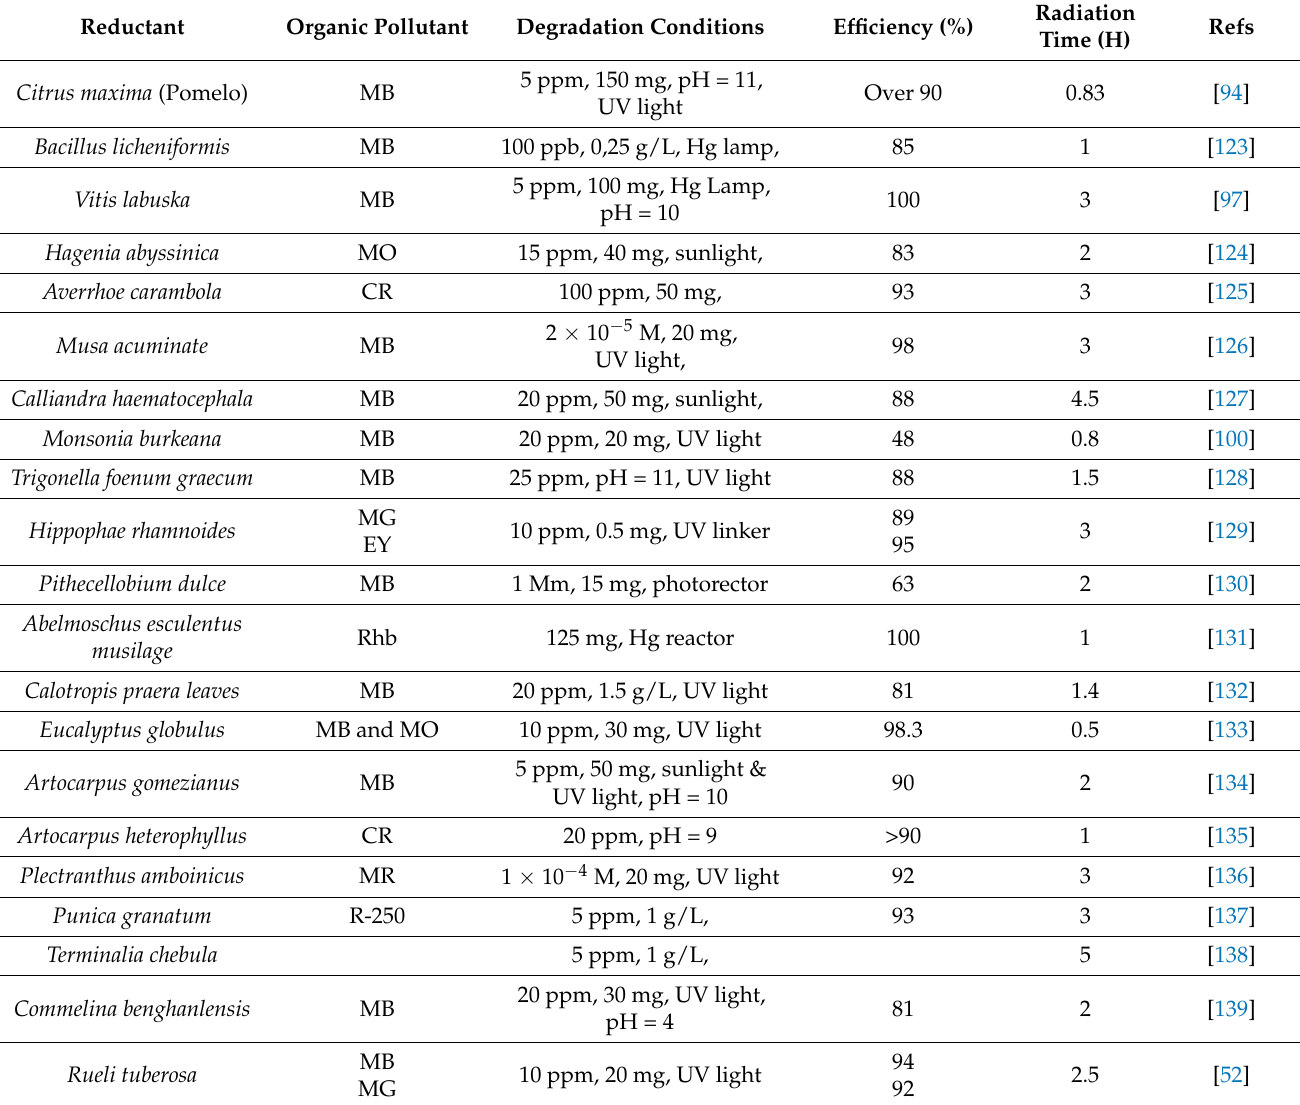
Table 4. Green synthesised metal oxides against different organic